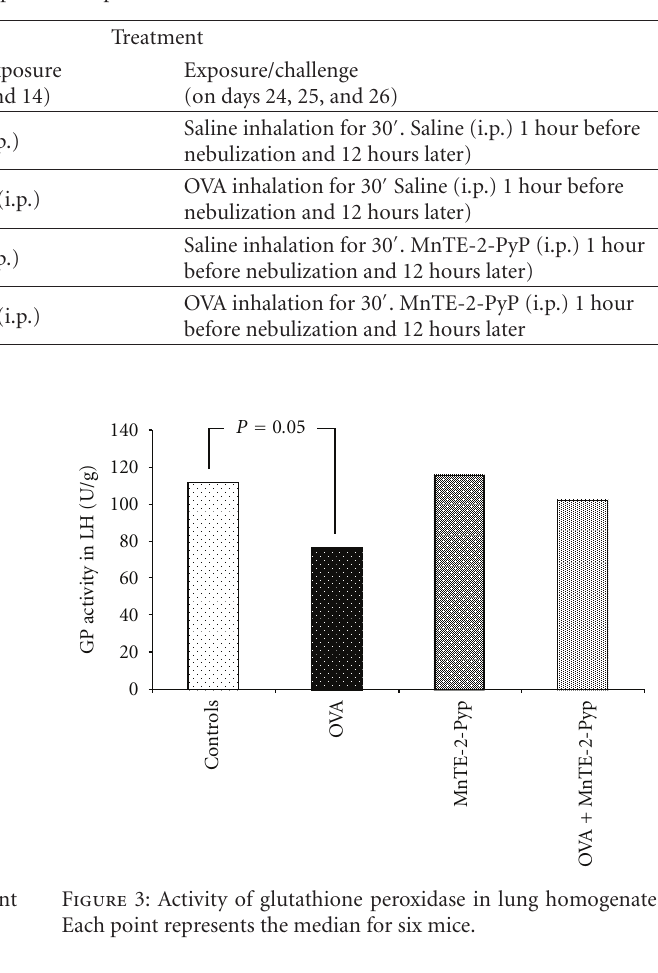
Table 1: Experimental protocol.